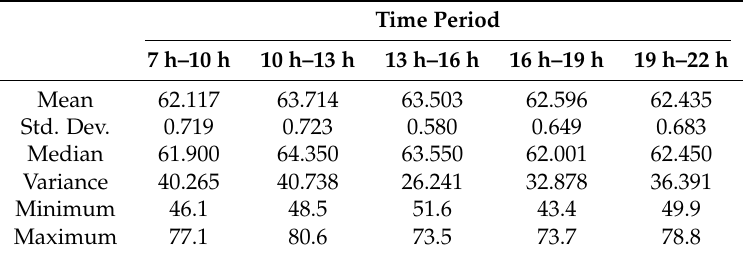
Table 2. Descriptive statistics of noise levels in different time periods.